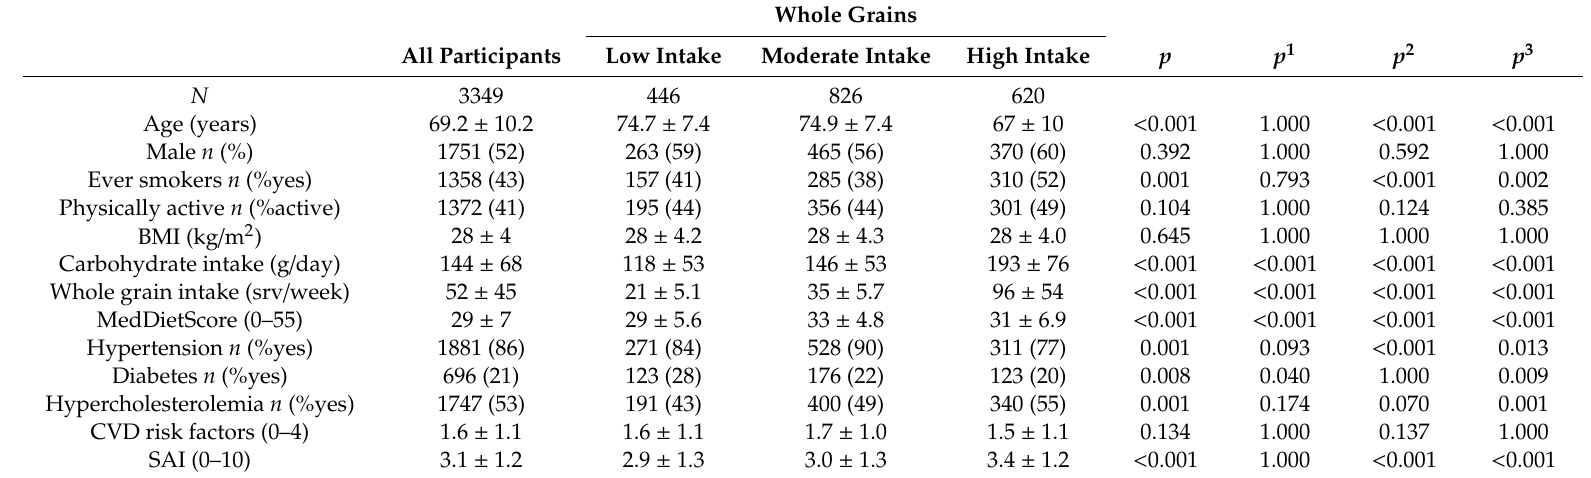
Table 1. Sociodemographic, lifestyle and clinical characteristics of the participants based on the weekly frequency of whole grain products. Whole Grains All Participants Low